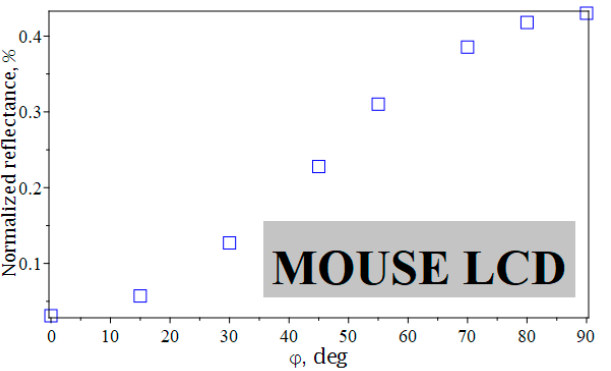
Figure 6. (Color online) Normalized reflectance of ORW e-paper versus the twist angle. Insert: the generated image includes maximum and minimum of the normalized reflectance [43].